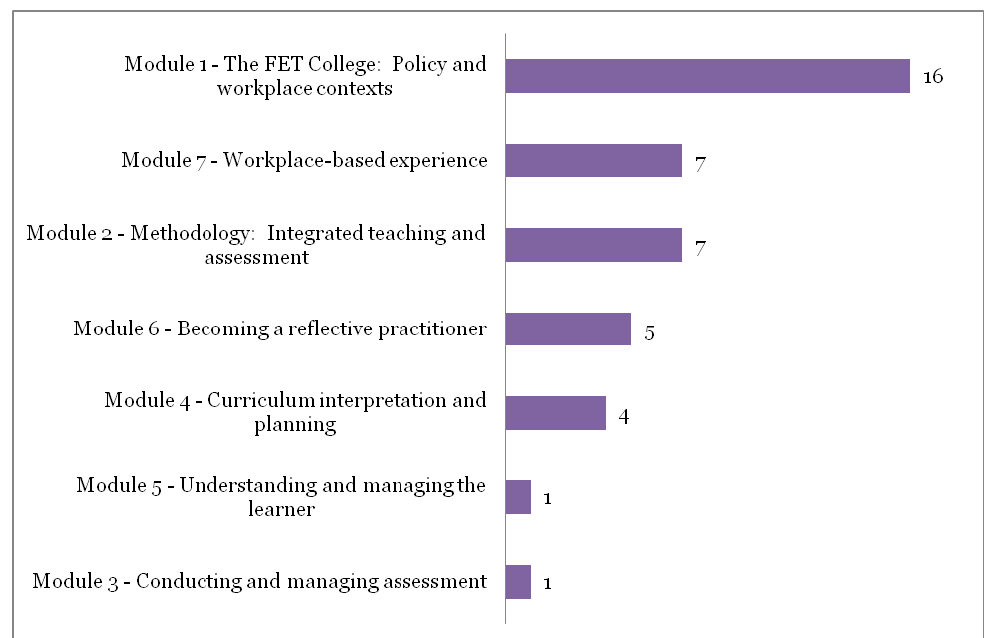
Figure 2 . Modules rated as the worst by the